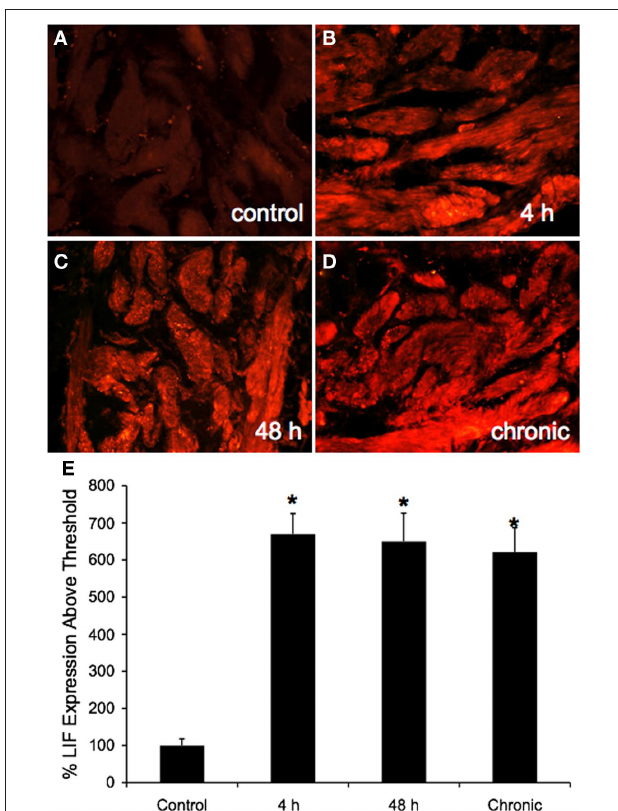
FIguRe 5 | Fluorescence photographs of LIF-immunoreactivity (IR) in detrusor smooth muscle in the bladder neck region in whole mount preparations of the urinary bladder in control (A), 4 h CYP-treated (B), 48 h CYP-treated (C), and chronic CYP-treated (D) rats. LIF-IR in the detrusor smooth muscle increased in density with CYP-induced cystitis (4 h, 48 h, chronic). (e) Summary histogram of percent LIF expression above threshold in detrusor smooth muscle with CYP-induced cystitis. Data are a summary of n = 6 for each group. * p ≤ 0.01 versus control. Calibration bar represents 80